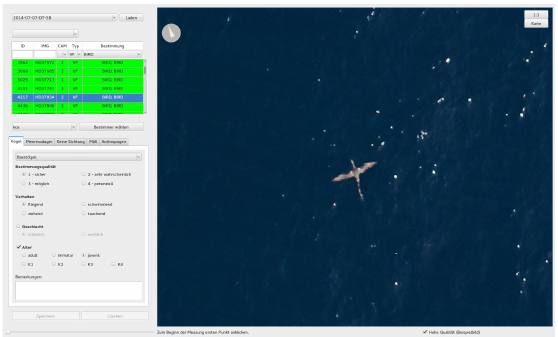
Figure 4. Screen shot of a software interface used for species